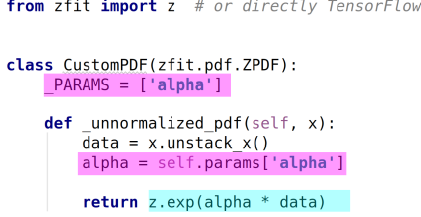
Figure 4. Implementation of the shape exp ( α · x ). The model class inherits from the base class and overrides one of the entry